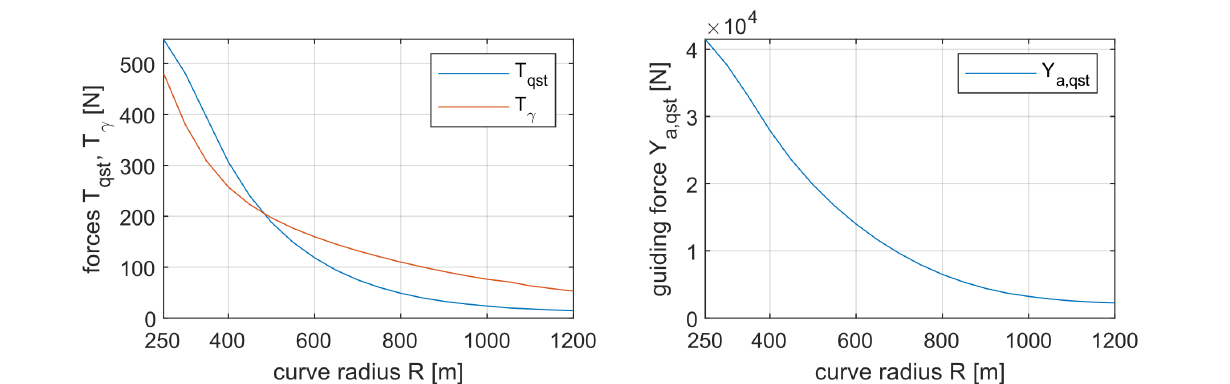
Figure 3. Basic comparison of the mentioned parameters used to evaluate RSD intensity depending on the curve radius R . Only for the guiding wheel on